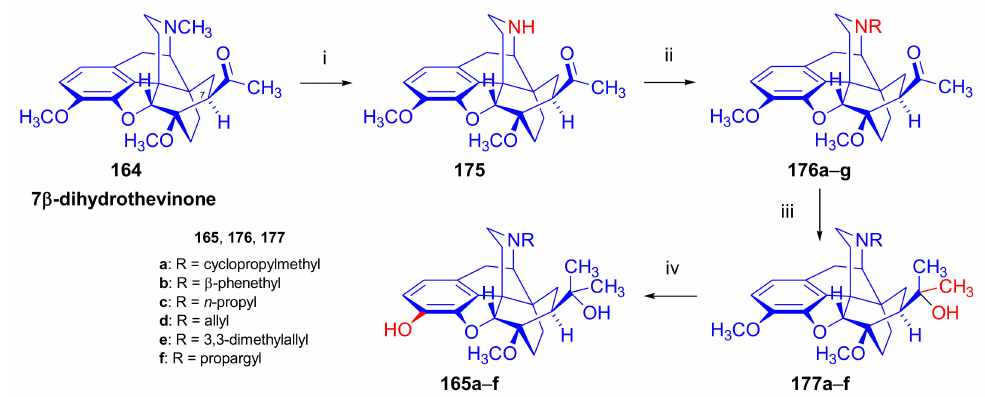
Figure 46. Synthesis of 7 β -diprenorphine and its N 17 -substituted derivatives. Reagents and conditions : (i): (1) DEAD, benzene, reflux, 16 h, (2) pyridine hydrochloride, EtOH; (ii): RBr, NaHCO 3 , DMF, 90 ◦ C, 20 h; (iii): methylmagnesium iodide, diethyl ether-toluene, 1 h; and (iv): KOH, diethylene glycol, 210 ◦ C.